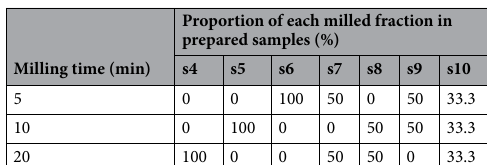
Table 2. Milled sand fraction mixing